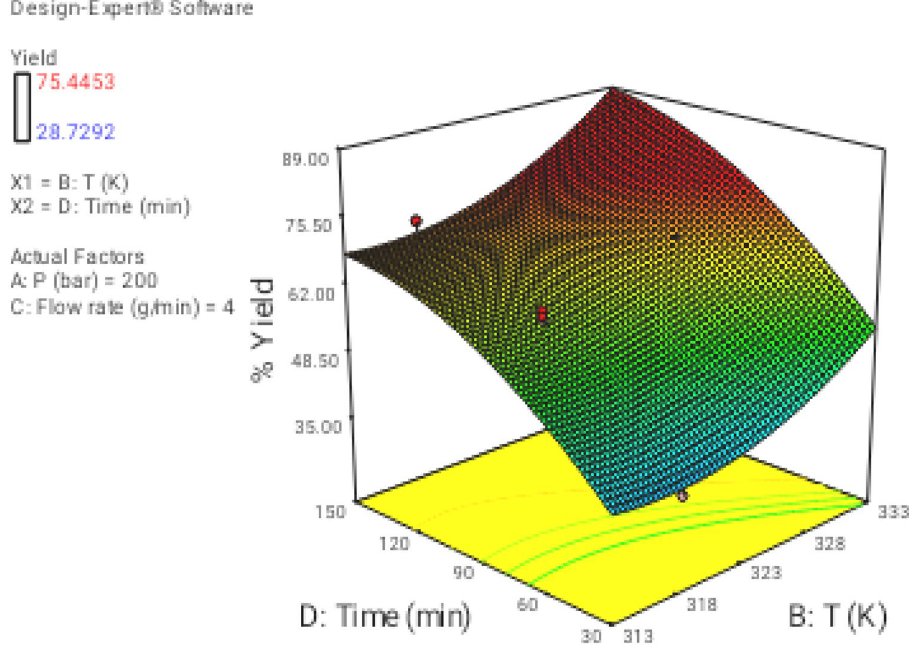
Figure 4. 3D graphic surface for the effects of temperature and time on the yield.